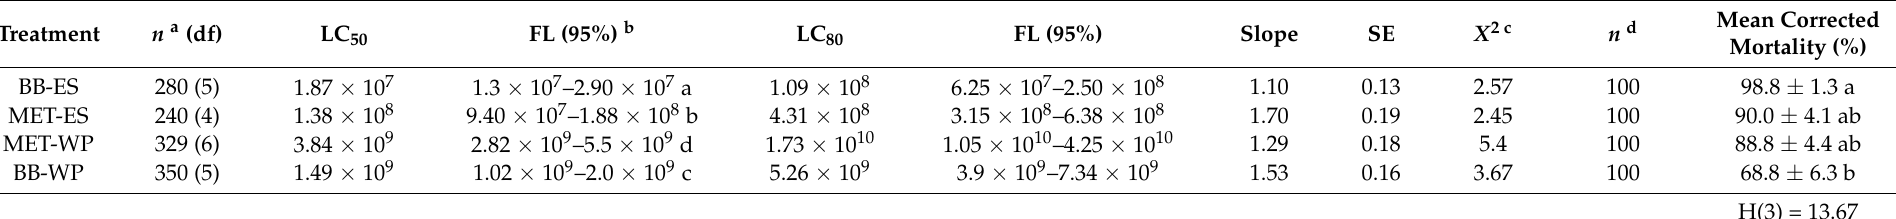
Table 3. Log-dose probit mortality data for Tuta absoluta pupae treated with different entomopathogenic fungal products and corrected percentage mortality for growth tunnel experiment.